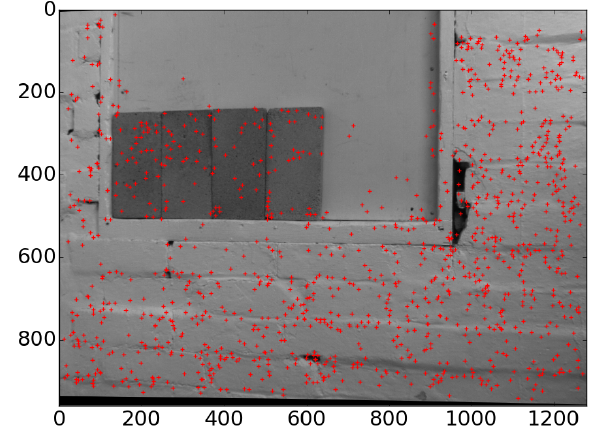
Figure 7 Matched SIFT keypoints, left stereo image, epipolar rectified.